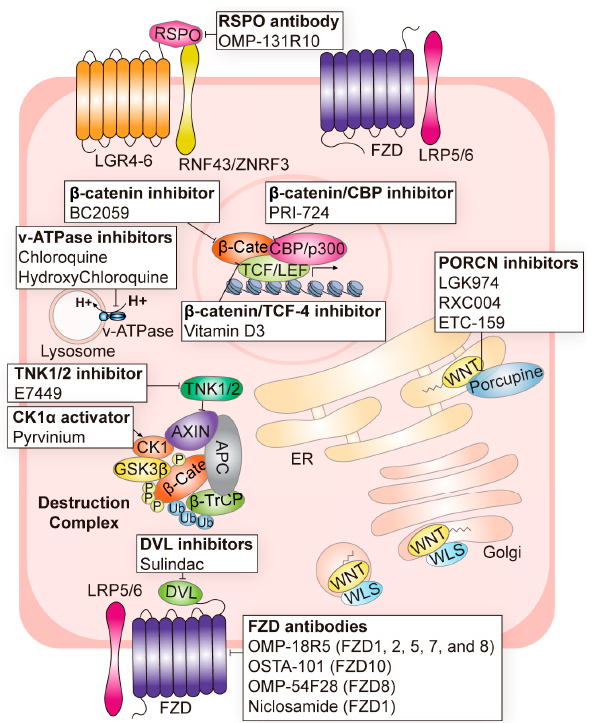
Figure 2. Wnt signaling modulating agents in clinical trials for cancer treatment. Promising clinical agents targeting the Wnt signaling module were displayed along with their targets.